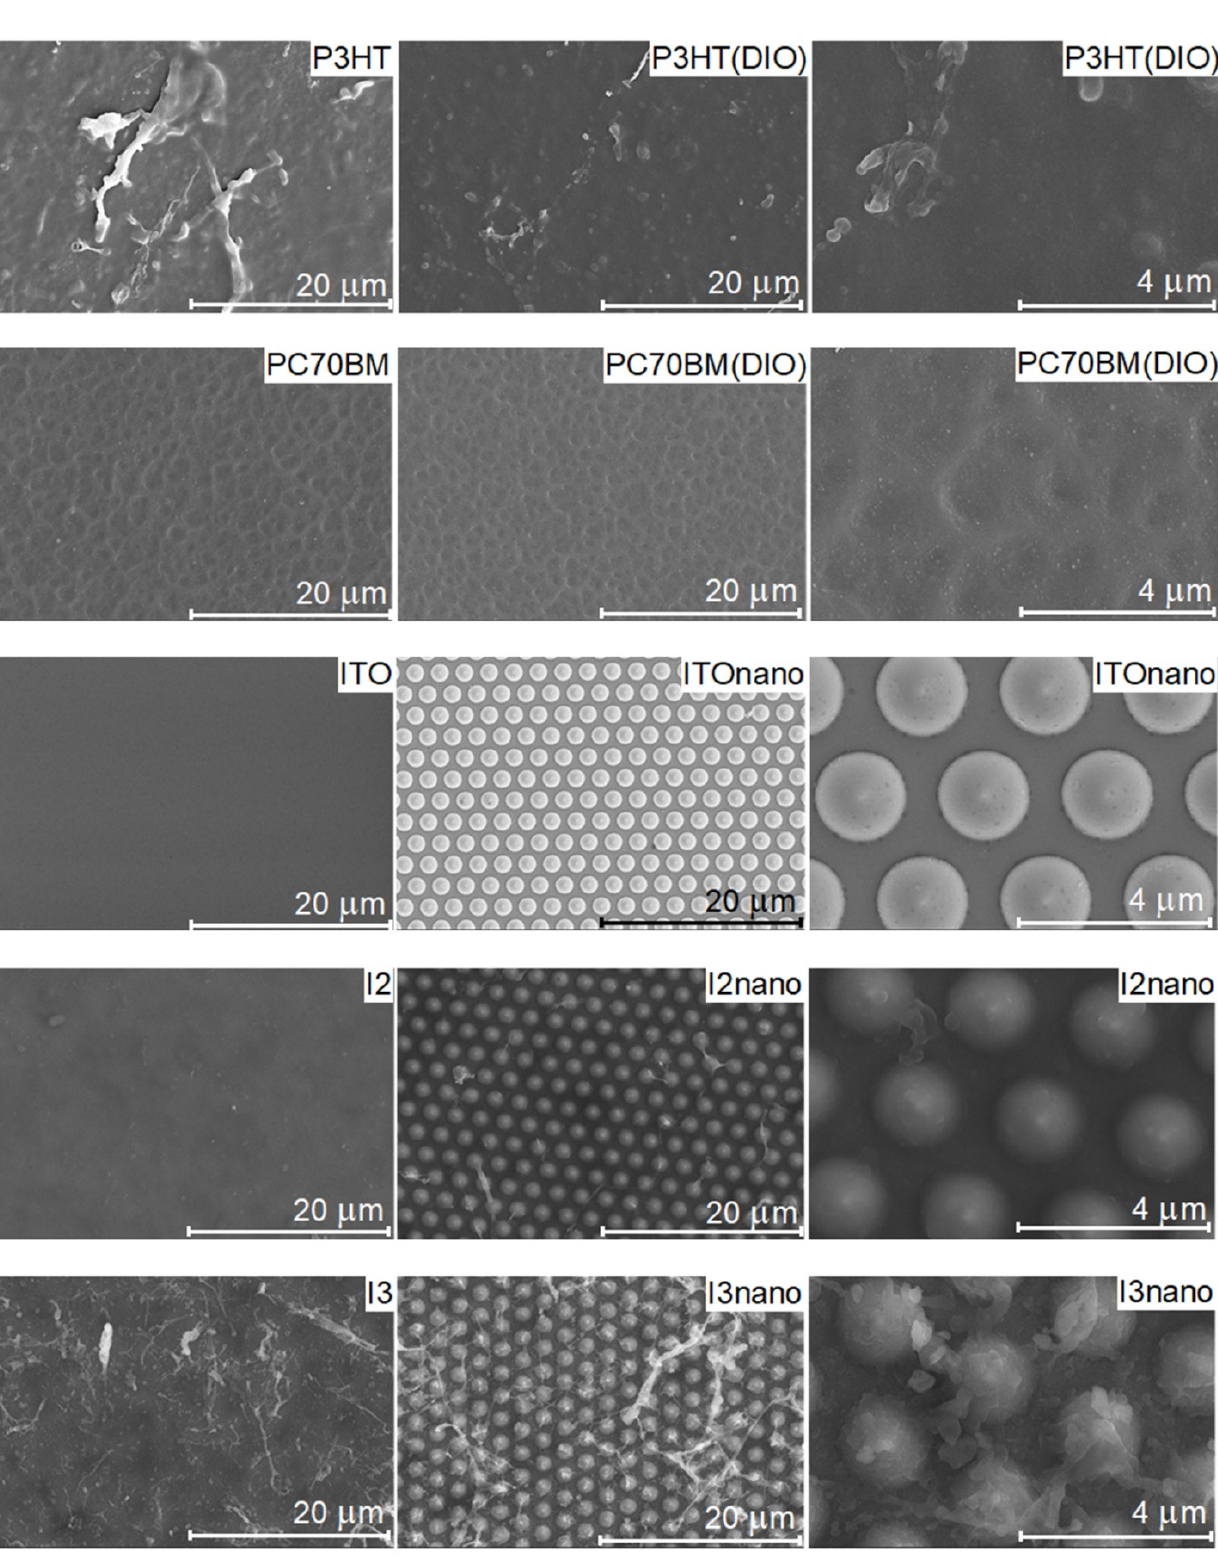
Figure 4. SEM images (at two magnifications) of the P3HT and PC70BM reference films deposited by MAPLE, flat ITO, and patterned ITOnano substrates and MAPLE blend layers: I2, I2nano deposited from the target P3HT:PC70BM (1:0.7) and I3, I3nano deposited from the target P3HT:PC70BM (1:1).